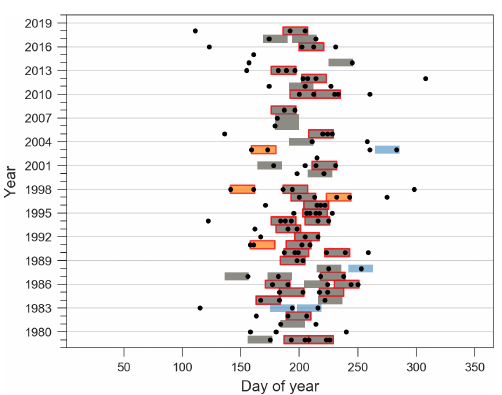
Figure A1. Catchment 4060460860 located in northeastern China, with prevalent clustering ( S cl = 41 . 14) and a high degree of simi- larity between the classifications Cl n and Cl acc : S cont = 0 . 93. All extreme events are shown as black dots, and 21d episodes are high- lighted by the coloured rectangles. Episodes appearing in both clas- sifications are shown in grey, and those appearing only in the Cl n classification are shown in orange, whereas those only in the Cl acc classification are shown in blue. A total of 34 episodes contain two or more extreme events ( n w > = 2) and are highlighted with a red edge.